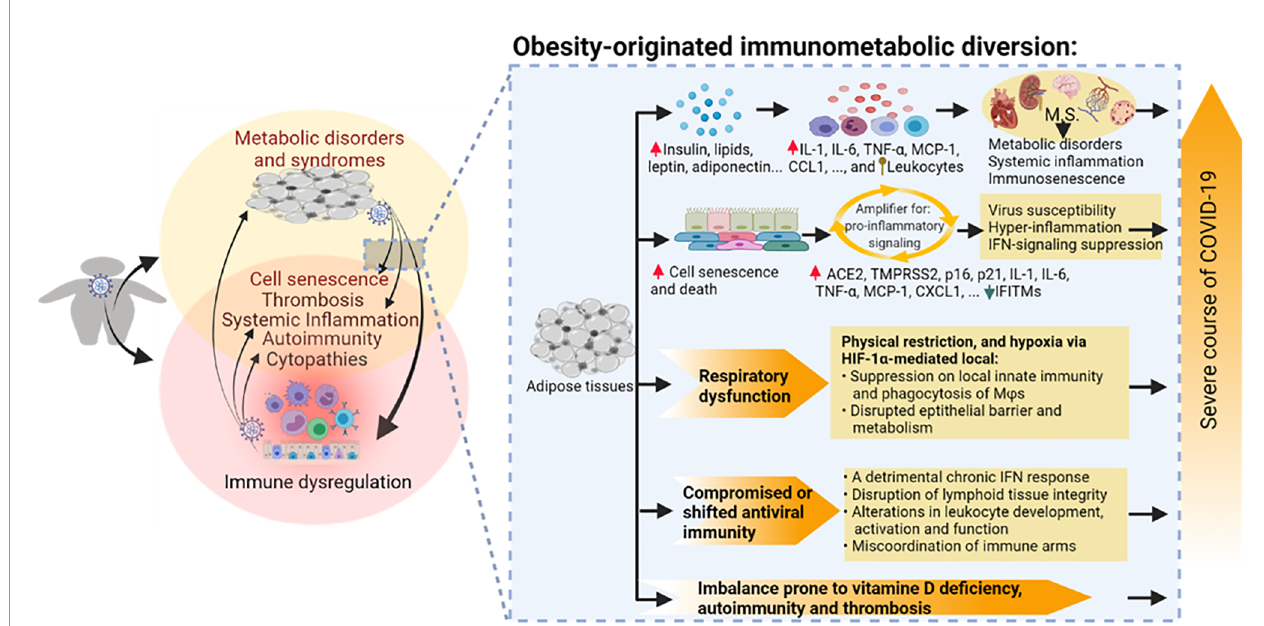
FIGURE 2 | Obesity-originated immunometabolic diversion underlying the association between obesity and the severe course of COVID-19 manifestations. Studies about obesity and associated metabolic disorders show the following: (1) increases of local and plasma mediators including leptin, insulin, glucose, lipids, and particularly various proin fl ammatory cytokines/leukocytes underlying relevant metabolic stress and in fl ammatory status accompanying excessive deposit of adipose tissues and development of metabolic disorders; (2) high incidences of cell senescence and death of adipocytes and associated epithelial and mesenchymal cells, which amplify proin fl ammatory signaling, dysregulate IFN-mediated antiviral response, and induce tissue expression of molecules facilitating SARS-CoV-2 susceptibility; (3) compromised or shifted antiviral immunity in both innate and adaptive arms; (4) respiratory obstruction resulting in hypoxia-mediated immune impairment; and (5) imbalance prone to autoimmune and thrombotic response. Arrowheads indicate increase (upward red) or decrease (downward green) of following molecular markers. Upward ball-head symbol ascribing abnormal chemotaxis and activation on leukocytes by obesity. ACE2, angiotensin converting enzyme 2; CCL, CC type chemokine ligand; CXCL, CXC type chemokine ligand; IFN, interferon; IFITM, interferon-induced trans-membrane proteins; IL, interleukin; MCP-1, monocyte chemoattractant protein-1; p16 and p21, cellular senescence marker protein 16 and 21; TMPRSS2, transmembrane Serine Protease 2; TNF, tumor necrosis